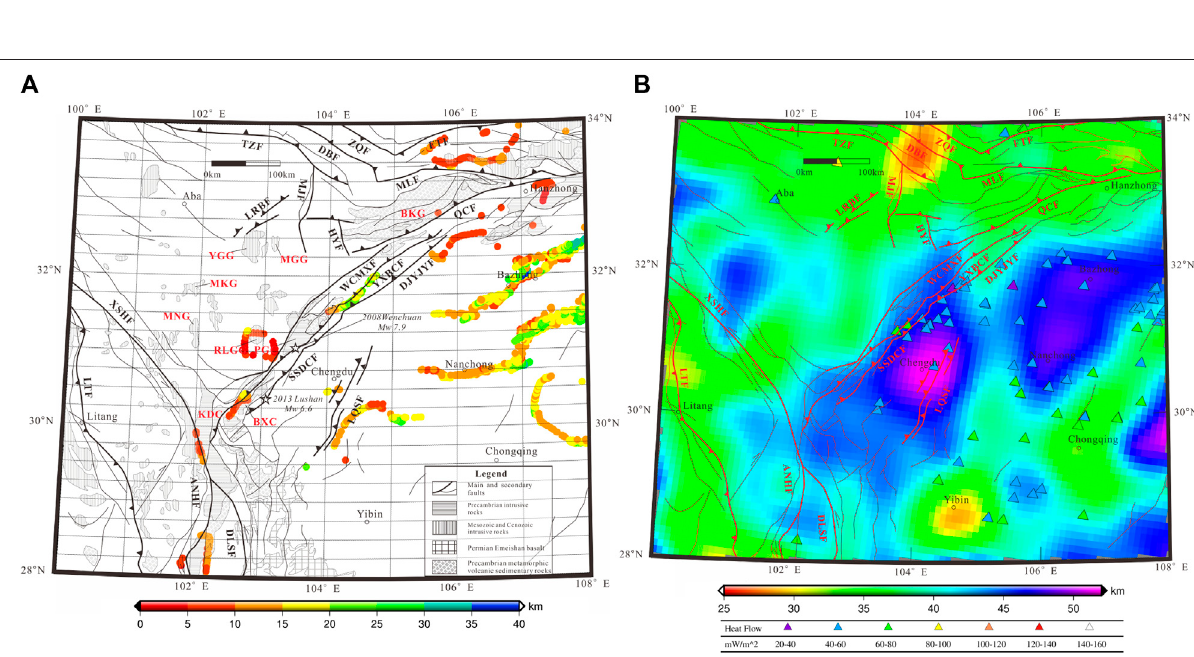
FIGURE 7 | (A) Estimation of the position of magnetic bodies using Euler deconvolution (SI = 0). The solid dots marked by different colors correspond to different buried depths. (B) Distribution of CPD around LFZ. The map is interpolated for better display. The triangles with different colors represent suface heat fl ow measurements. The heat fl ow data come from Jiang et al.